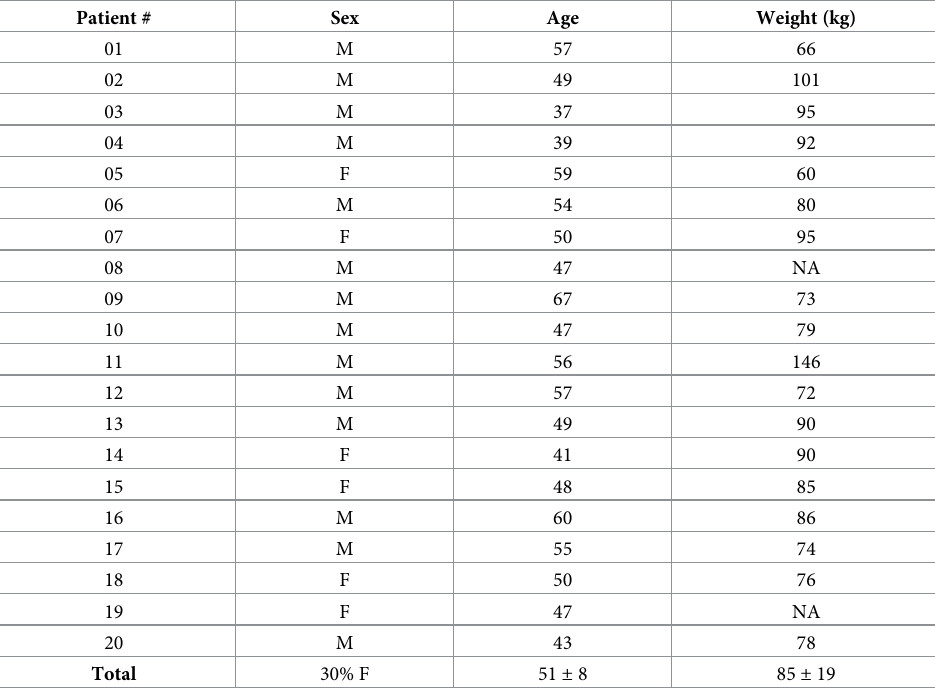
Table 2. Demographics of the patients undergoing CT scans. NA stands for not available. Patient